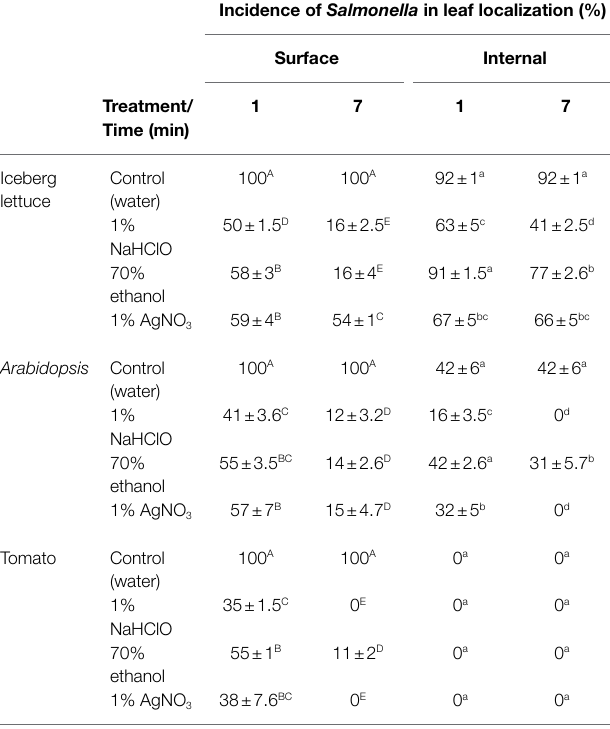
TABLE 2 | Incidence of fluorescent Salmonella cells in various leaf localization using confocal microscopy. Incidence of Salmonella in leaf localization